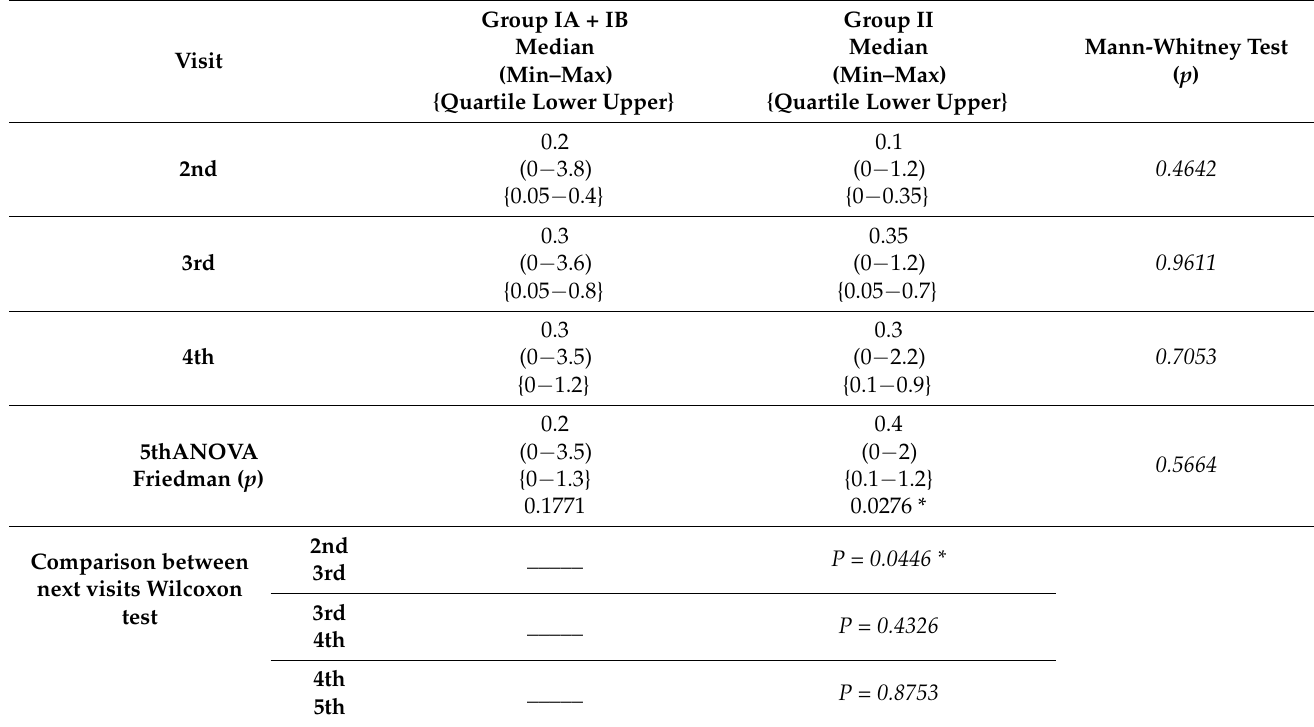
Table 4. Changes in radiological length of endodontically treated teeth (mm) at subsequent appointments.